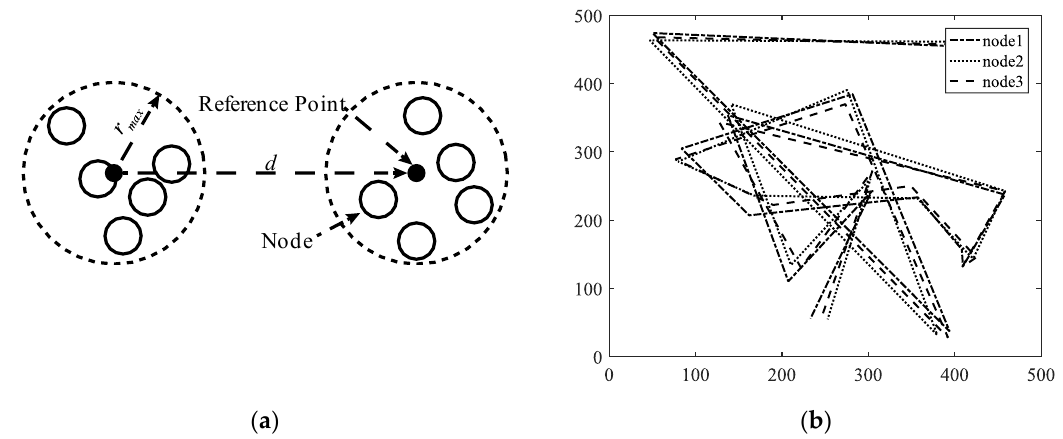
Figure 7. Column mobility models: ( a ) Example of a single step in Nomadic Community (NC) with